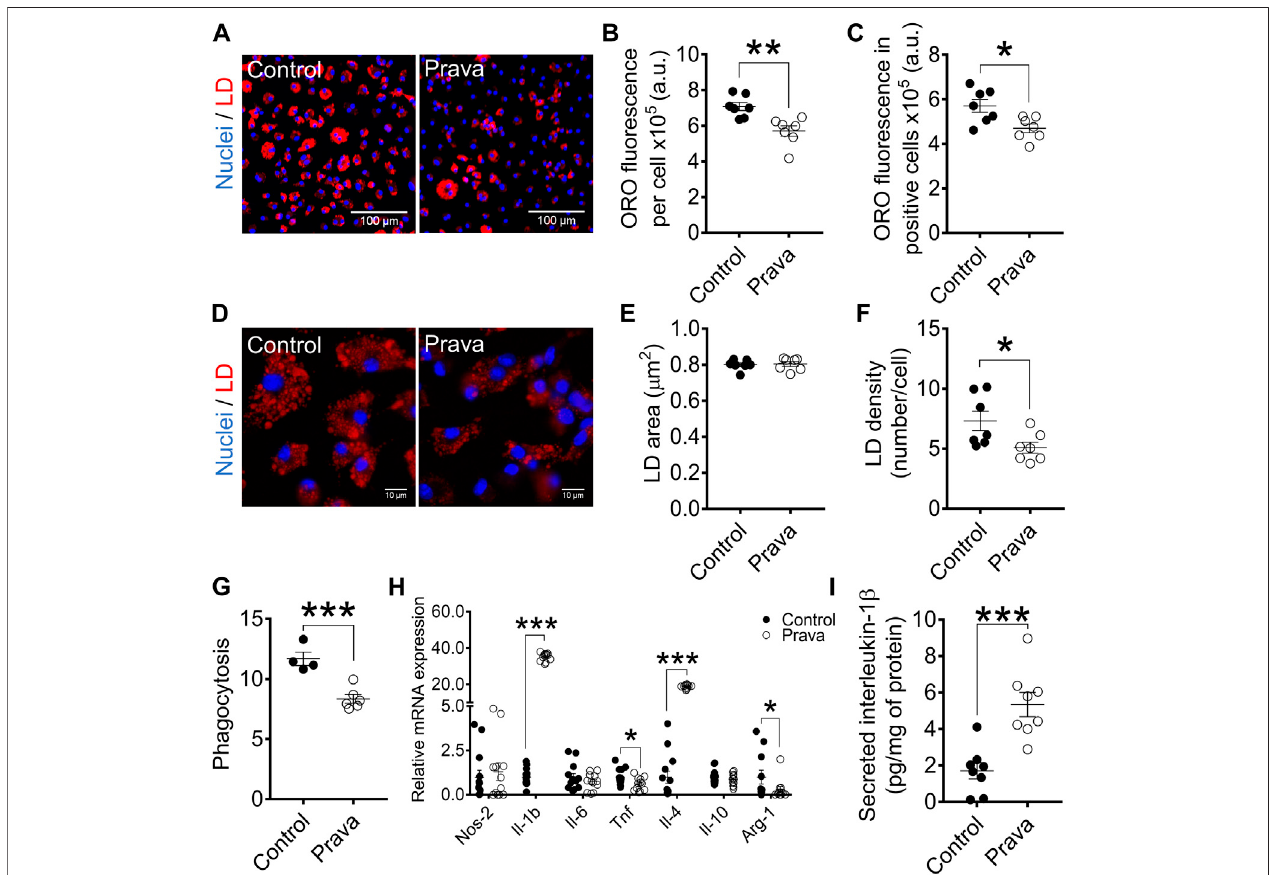
FIGURE 6 | Pravastatin treatment decreases foam cell formation, lipid droplets density, and phagocytosis and modulates either pro- and anti-in fl ammatory gene expression in BMDM. (A) Representative images at 10×magni fi cation of BMDM from non-treated (control) and pravastatin-treated (prava) LDLr − / − mice after incubation with ox-LDL. Neutral lipids were stained with ORO fl uorescent dye (red) and nuclei with Hoechst33342 (blue). Quantitative analysis of ORO fl uorescence intensity in all cells (B) and in positivecells (C) . (D) Representative images of lipid droplets at 60× magni fi cation and stained withORO(red) and nuclei with Hoechst33342 (blue). Quantitative analysis of lipid droplets ’ size (E) and density (F) from images displayed in (D) . Three replicates per mouse were considered, each corresponding to the average ofnine fi elds analyzed by fl uorescence microscopy. Control: n = 7 mice and prava: n = 7 mice. (G) Zymosan phagocytosis. Control: n =4 mice and prava: n = 6 mice. Two replicates per mouse. (H) Relative mRNA expression of in fl ammatory-related genes. Control: n = 13 mice and LDLr − / − : n = 12 mice, with 2 replicates for each gene. Data are expressed as mean ± SE. (I) Interleukin-1 β (Il-1 β ) secretion in cell supernatant and normalized by protein content in the cell lysate. Data are expressed as mean±SE.Control: n =8miceandprava: n =8mice,with2replicatesforeachmouse.Statisticalanalyseswereperformedusingtwo-tailedunpairedStudent ’ st-test.*, **, and *** represent p < 0.05, 0.01, and 0.001,